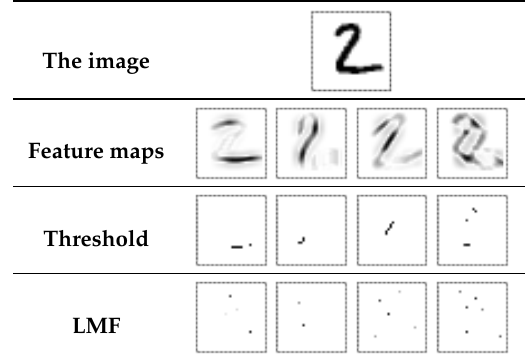
Table 1. Local-maximum filtering (LMF) is a method that generates a sparse output, but is more practical than the standard thresholding. The points are designed to reflect the selected visual features of the image, and the local-maximum filtering makes it possible for each point to reflect a different occurrence of a feature. Thus, it is necessary to employ a mechanism preventing non-zeroed points from being located too close to each other. The strongest activated points are chosen in a greedy way, with only one point allowed in each s × s square. The presented illustration shows the result for s =